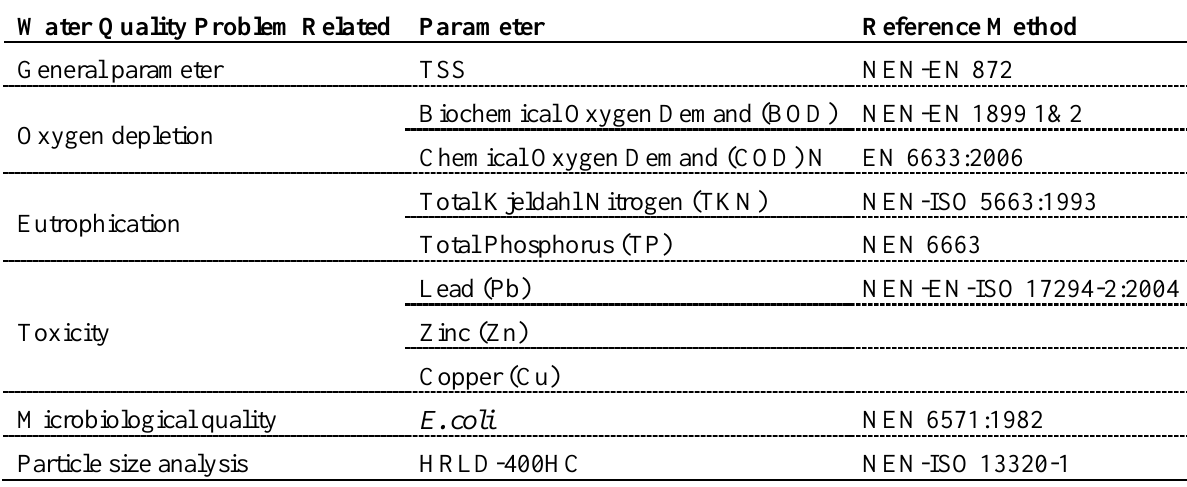
Table 1. Water quality parameters